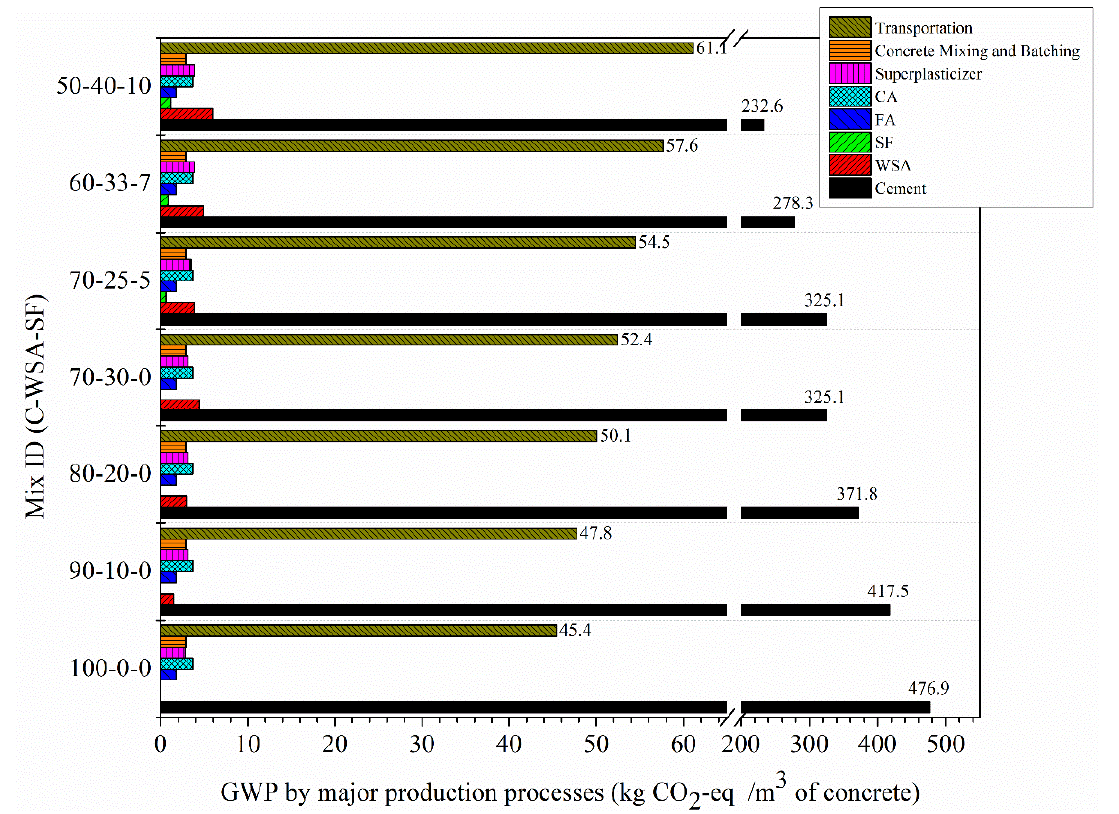
Figure 11. Comparison of GWP distribution by concrete ingredient and phase between control, binary (C/WSA), and ternary (C/WSA/SF) concrete mixtures.